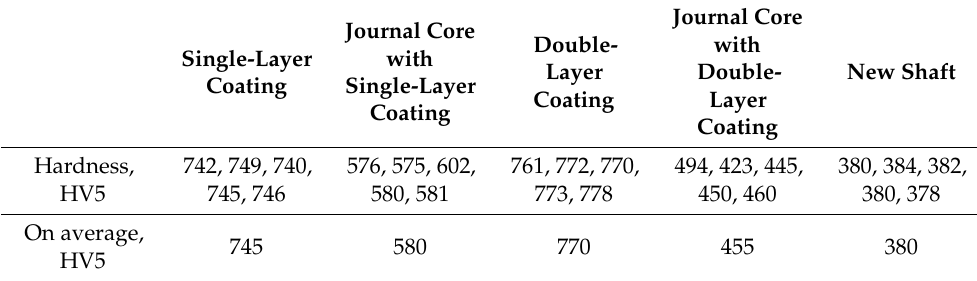
Table 2. HV5 hardness values of coatings and journal cores of turbocharger